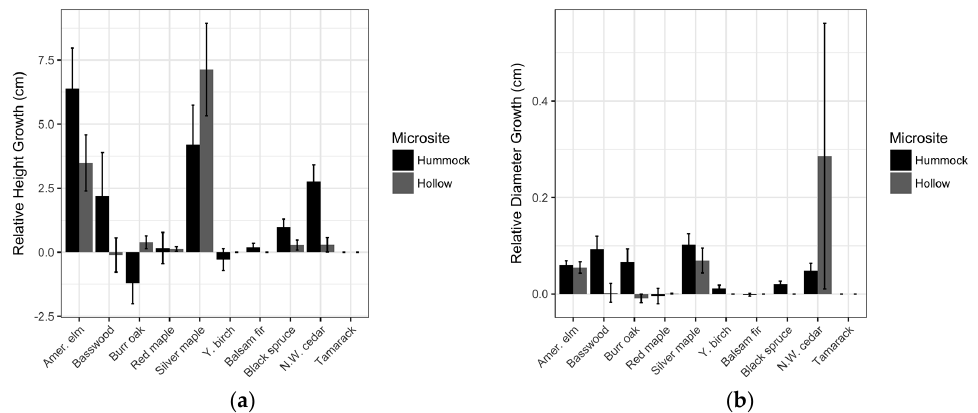
Figure 2. ( a ) Relative growth of height (cm) and ( b ) diameter (cm) of the 10 wetland-adapted tree species (American elm, basswood, burr oak, red maple, silver maple, yellow birch, balsam fir, black spruce, northern white cedar, tamarack) planted across three black ash-dominated wetlands in the Ottawa National Forest over the 3-year study period. The bars represent the mean relative growth rate for each species by microsite condition. The error bars represent ± one standard error.